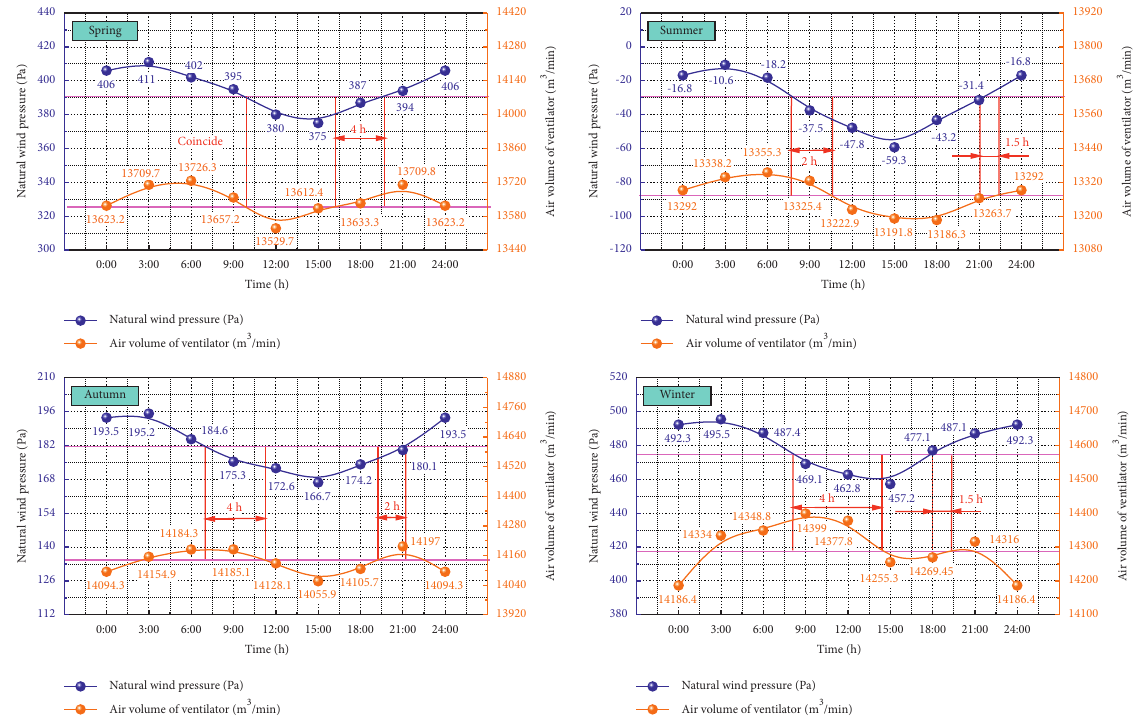
Figure 7: Changes of natural wind pressure and ventilator air volume on one representative day in each of four are basically 0, and thus the pressure inside the airtight space